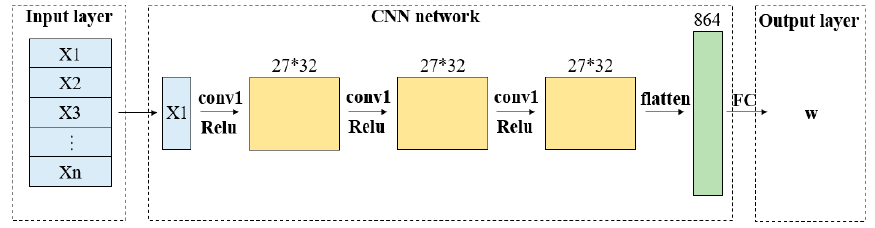
Figure 2. CNN model structure (Conv: Convolution layer, FC: fully connected